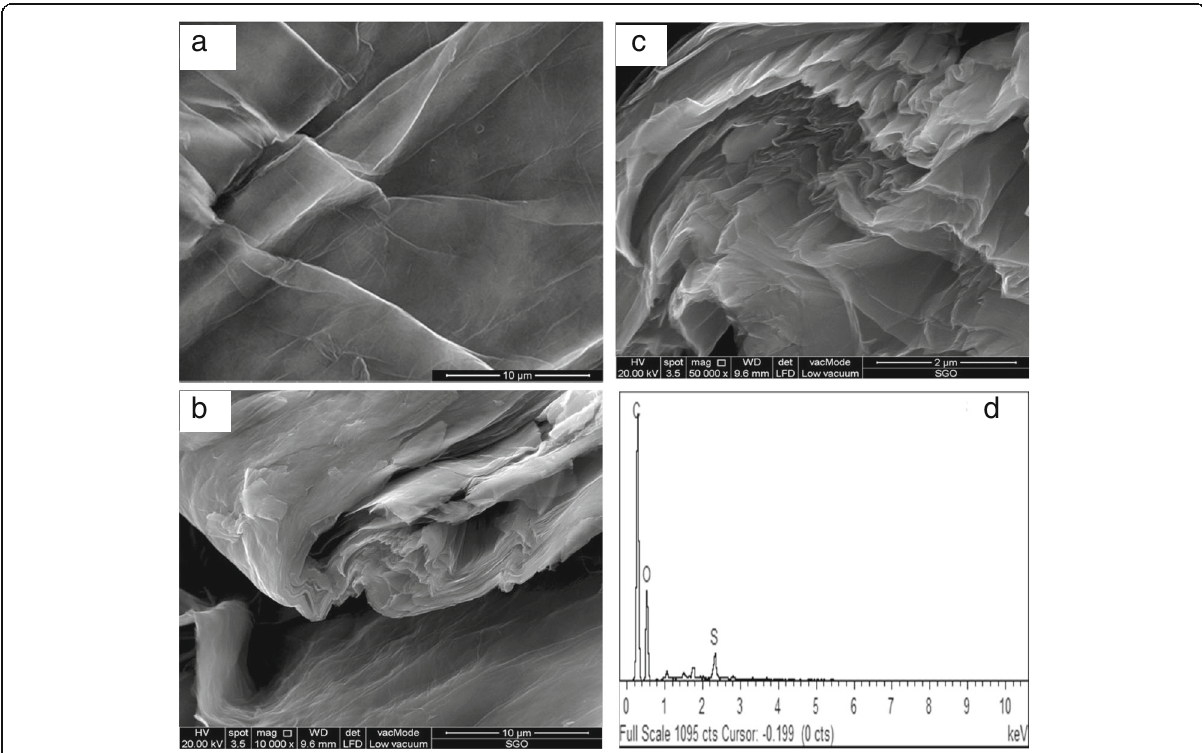
Fig. 3 a FESEM image of GO. b , c FESEM images of SGO with various magnification and d EDX of